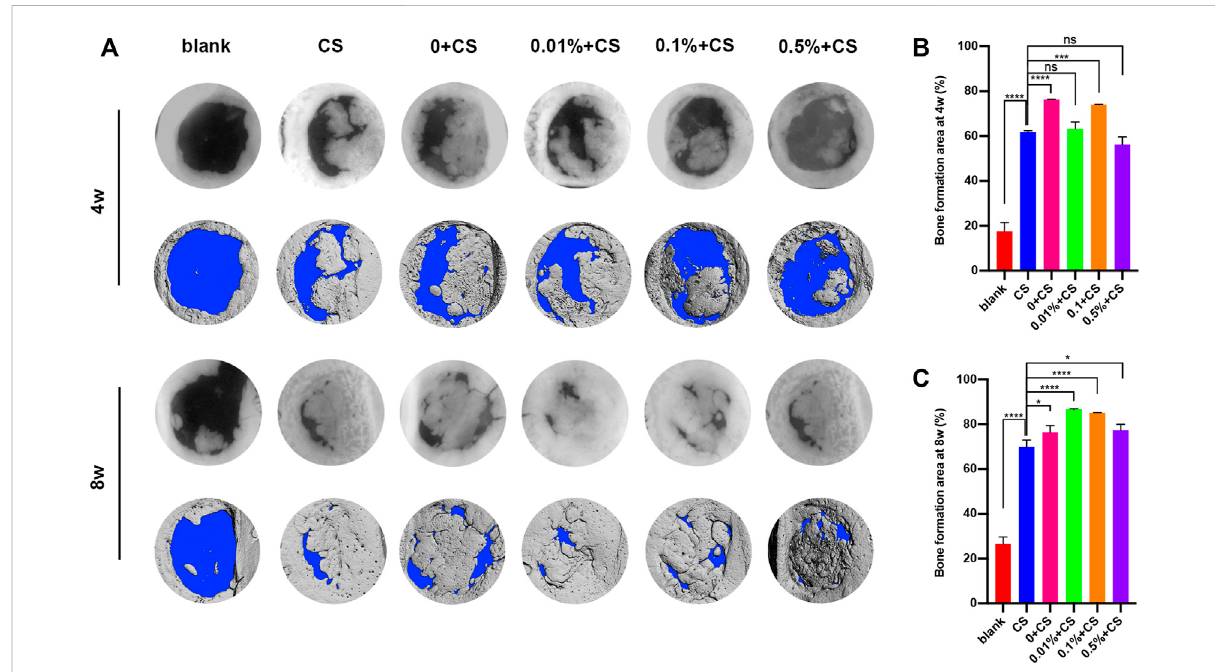
FIGURE 5 Radiographs and micro-CT analysis of bone regeneration in rat critical size calvarial defects at 4 and 8 weeks postoperatively (A) and quanti fi cation analysis of the regenerated tissue covering the calvarial defect at 4 w (B) and 8 w (C) . (The CS group was used as control: * p <